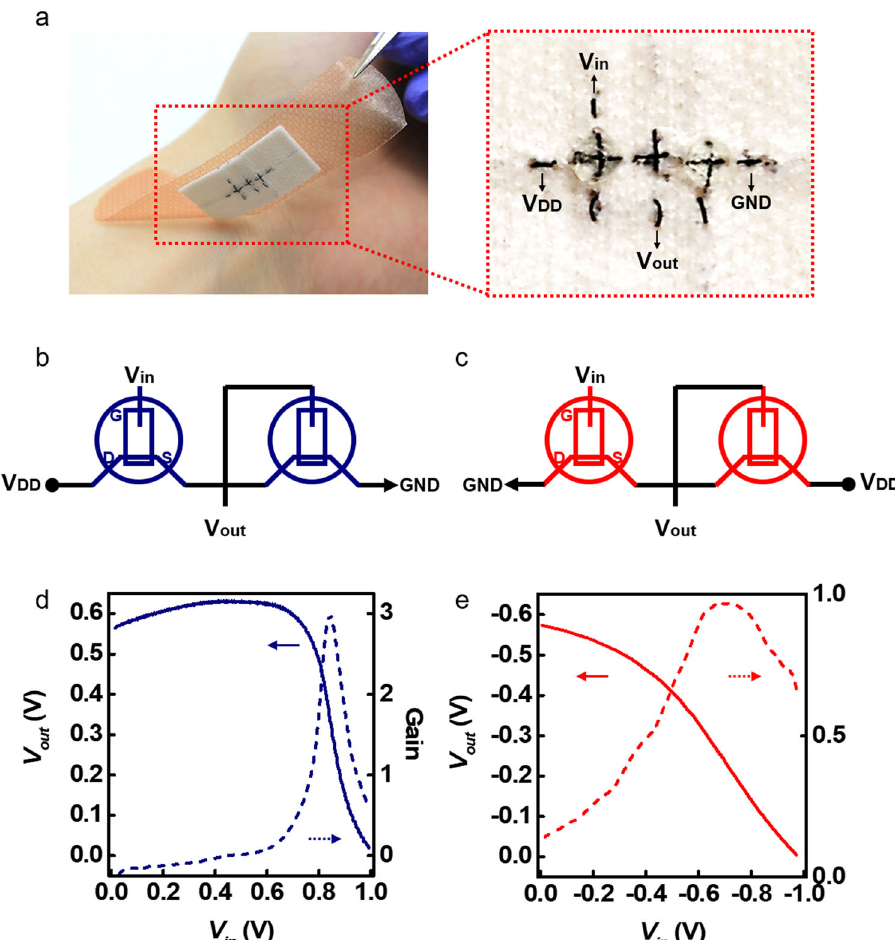
Fig. 5 Inverters composed of interdigitated OECT with PEDOT:PSS conductive gel fi ber. a Integrated circuit of zero-V GS implemented by suturing in a plaster. Equivalent circuits of b depletion-mode OECTs based and c enhancement-mode OECTs based inverters. d , e Corresponding transfer characteristics of inverters (navy: depletion-mode OECTs based inverter, red: enhancement-mode OECTs based inverter) at |V_DD | = 0.6